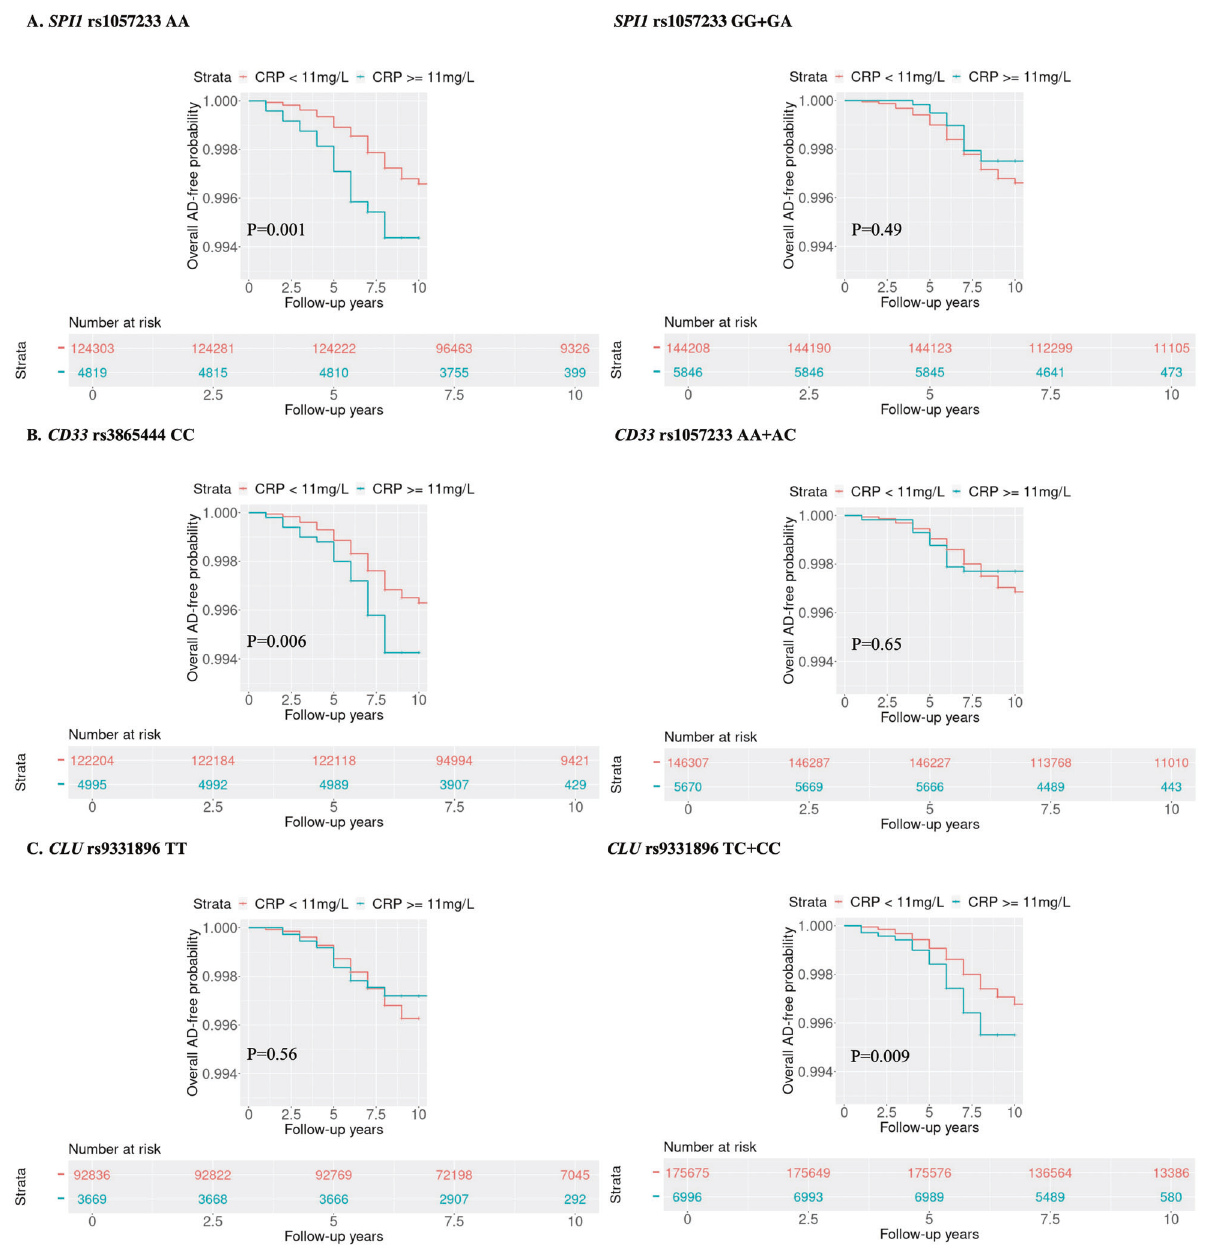
Fig. 2 Kaplan ‒ Meier analysis in UKBB for AD-free probability under different CRP levels (mg/L) among genotypes in 3 SNPs. A SPI1 rs1057233 - AA vs. rs1057233-GG + GA. B CD33 rs3865444-CC vs. rs3865444-AA + AC. C CLU rs9331896-TT vs. rs9331896-CC + CT genotypes. Red: CRP < 11 mg/L, Green: CRP ≥ 11 mg/L. Raw P values are